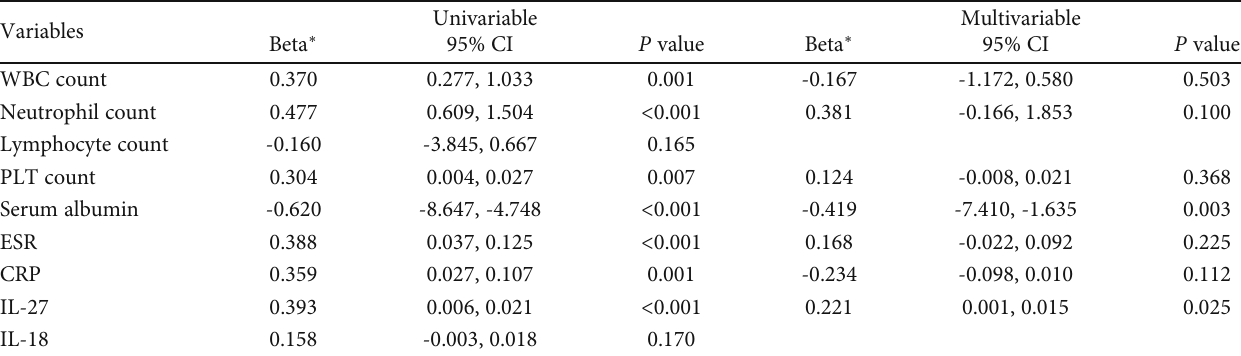
Table 2: Linear regression analysis of in fl ammation-related variables and serum IL-27 and IL-18 levels with the cross-sectional BVAS. Variables